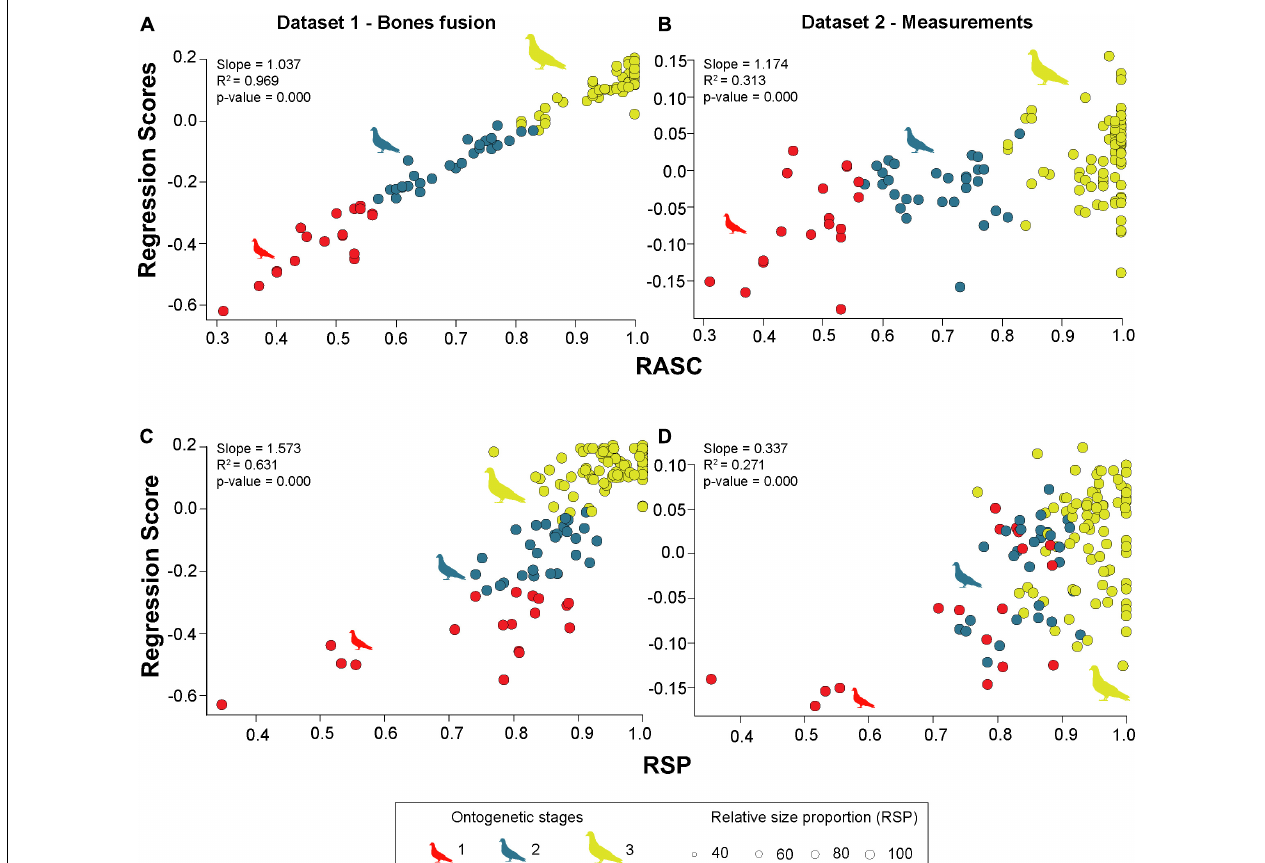
FIGURE 4 | Multivariate regression of PCoA results against RASC (relative average sutural closure) and RSP (relative size proportion) for dataset 1 and dataset 2. (A) OLS regression between regression scores (PCoA of dataset 1) against RASC . (B) OLS regression between regression scores (PCoA of dataset 2) against RASC . (C) OLS regression between regression scores (PCoA of dataset 1) against RSP . (D) OLS regression between regression scores (PCoA of dataset 2) against RSP . All silhouettes are taken from www.phylopic.org/.